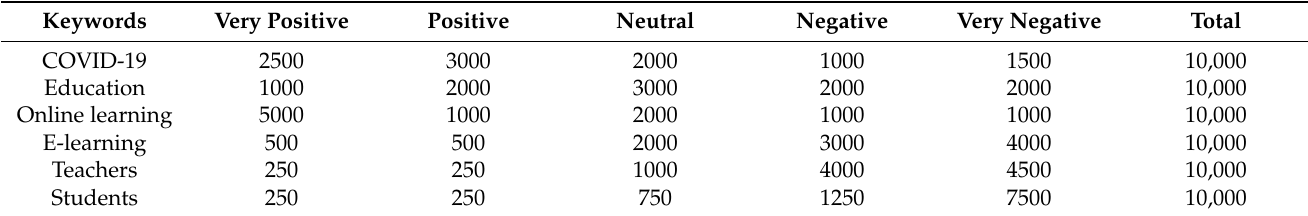
Table 1. Gold standard corpus statistics are based on the names of